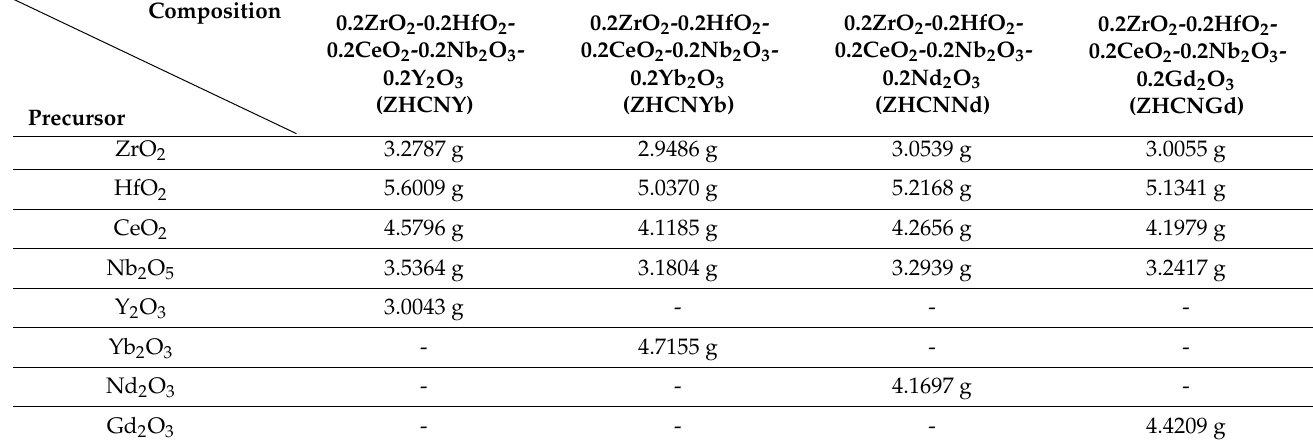
Table 1. Precursor amount for heterovalent equimolar quinary oxide system of ZrO 2 -HfO 2 -CeO 2 -Nb 2 O 5 -RE 2 O 3 type (RE = Y, Yb, Nd,